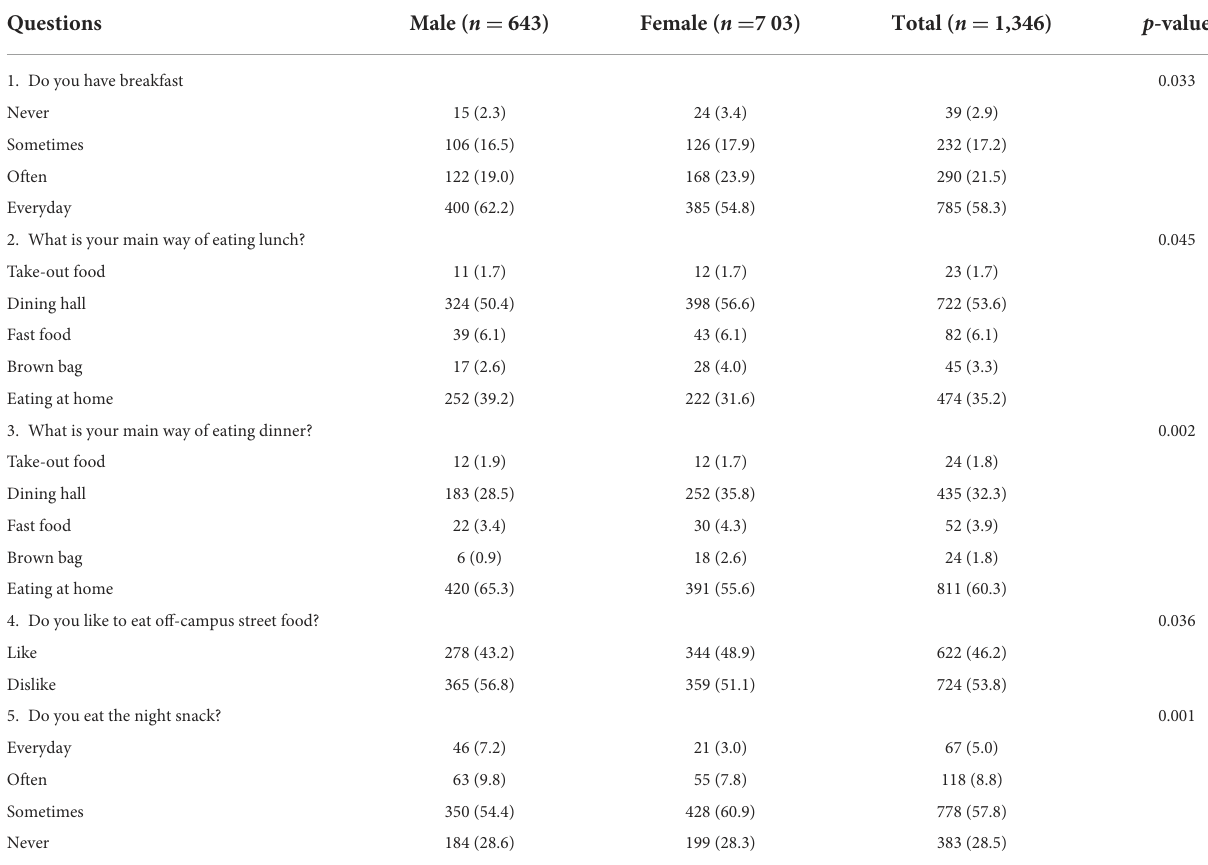
TABLE 1 Participants’ responses to questions related to nutritional